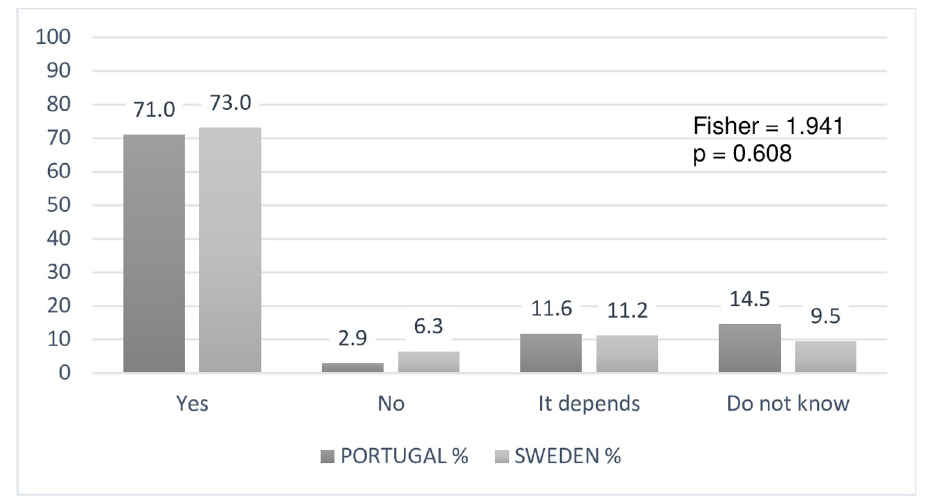
Fig 3. Teachers´ perceptions about DHH students’ visual skills (N = 133).